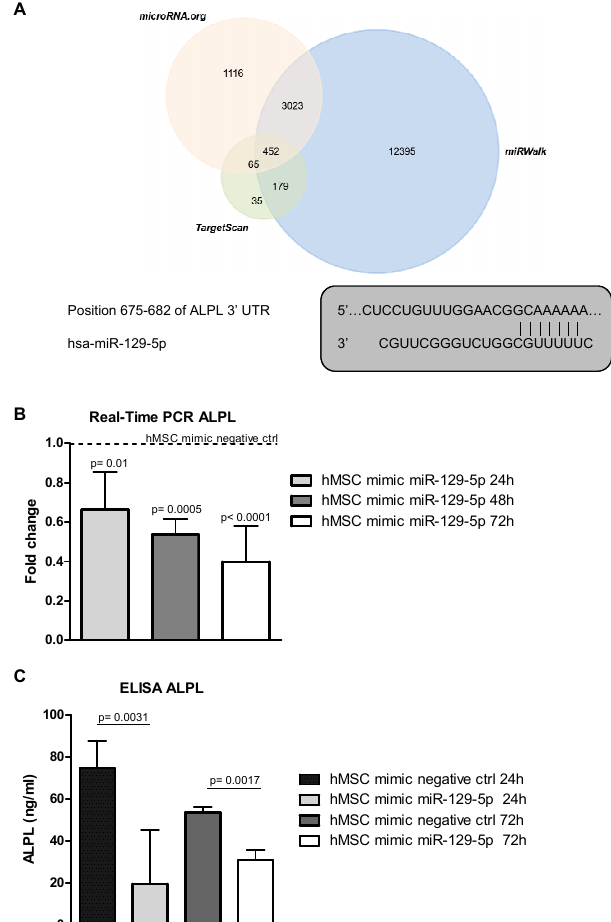
Figure 5. ( A, upper panel ) The target genes of hsa-miR-129-5p were predicted using three di ff erent bioinformatics databases (Target scan, miRWalk and microRNA.org). TheVenn diagram was generated using the FunRich tool available online. ( A, lower panel ) The sequence alignment between miR-129-5p and the 3 (cid:48) -UTR of ALPL mRNA predicted by TargetScan. ( B ) The Real-time PCR analysis of ALPL in hMSCs transfected for 24, 48 and 72h with miR-129-5p mimic. Data were normalized for β -actin. Values are expressed as Fold Change in gene expression that occurred in cells transfected with miR-129-5p mimic versus hMSCs transfected with mimic negative ctrl for each time point (dotted line). The statistical significance of the di ff erences was analyzed using a two-tailed Student’s t -test. ( C ) ALPL release was quantified by ELISA in the supernatant of hMSCs transfected for 24 and 72h with miR-129-5p mimic and with mimic negative ctrl. Values are reported as ALPL concentration in ng / mL. The statistical significance of the di ff erences was analyzed using a two-tailed Student’s t